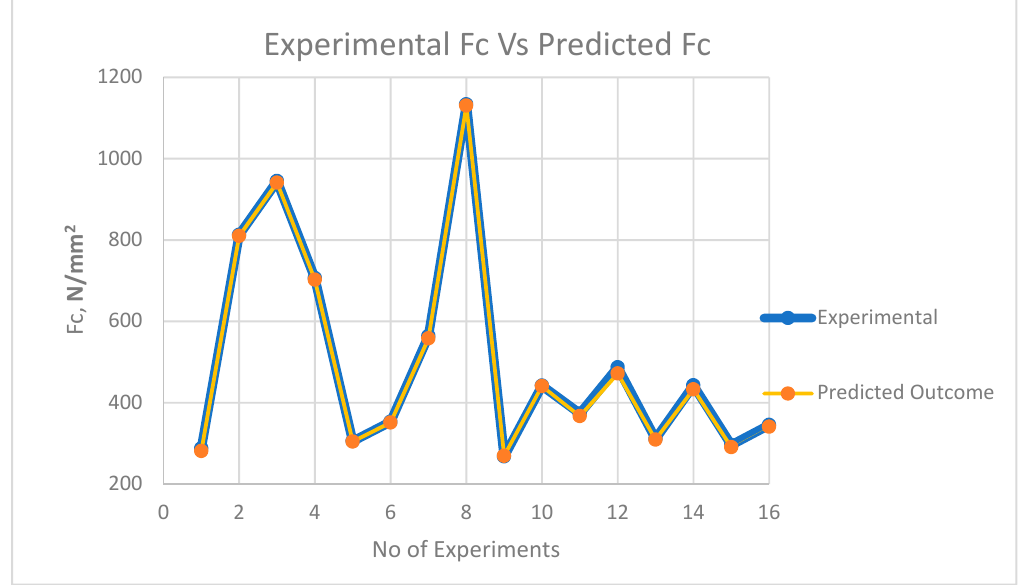
Figure 10. Plot of experimental cutting force (Fc) vs. predicted cutting force (Fc).